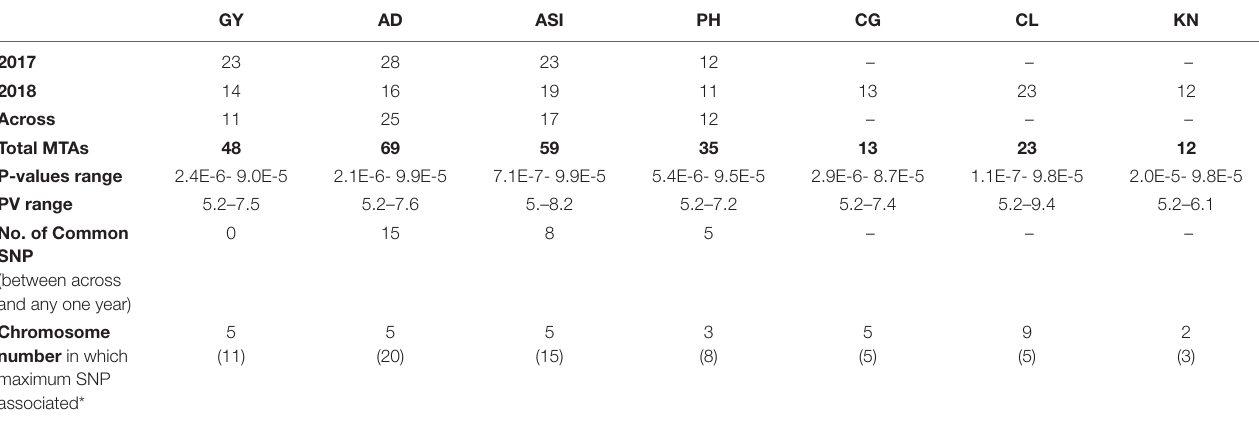
FIGURE 1 | Linkage disequilibrium (LD) decay for the association mapping panel. TABLE 2 | Details of marker-trait associations identified for the traits under salinity stress.